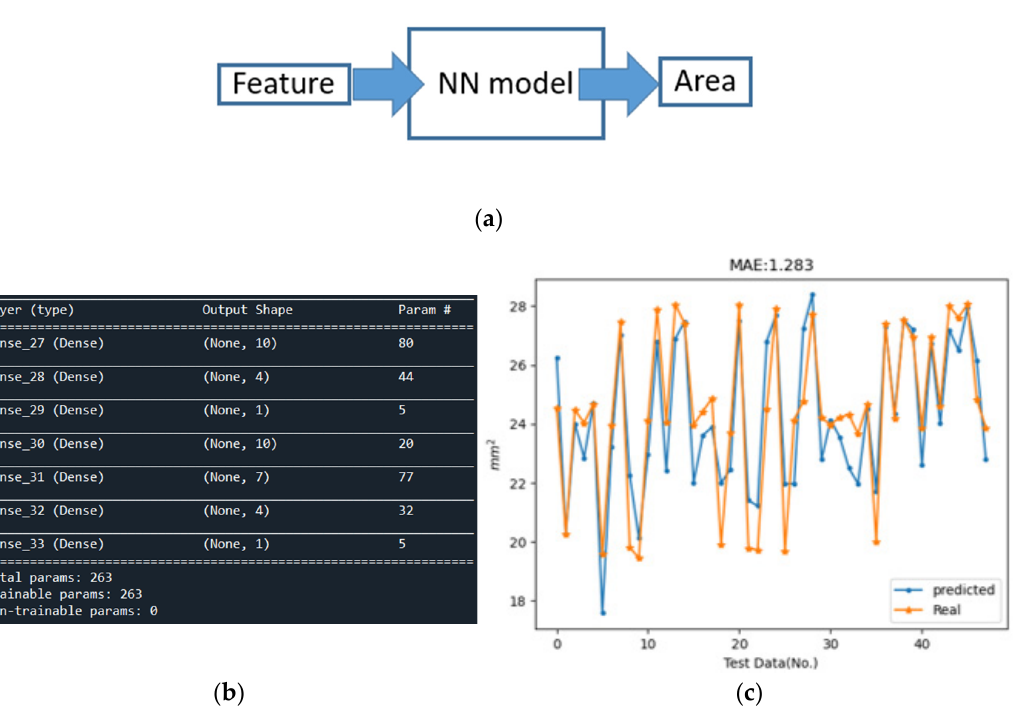
Figure 17. ( a )The configuration of EDM model; ( b ) model information; ( c ) The results of predicted and real data of EDM